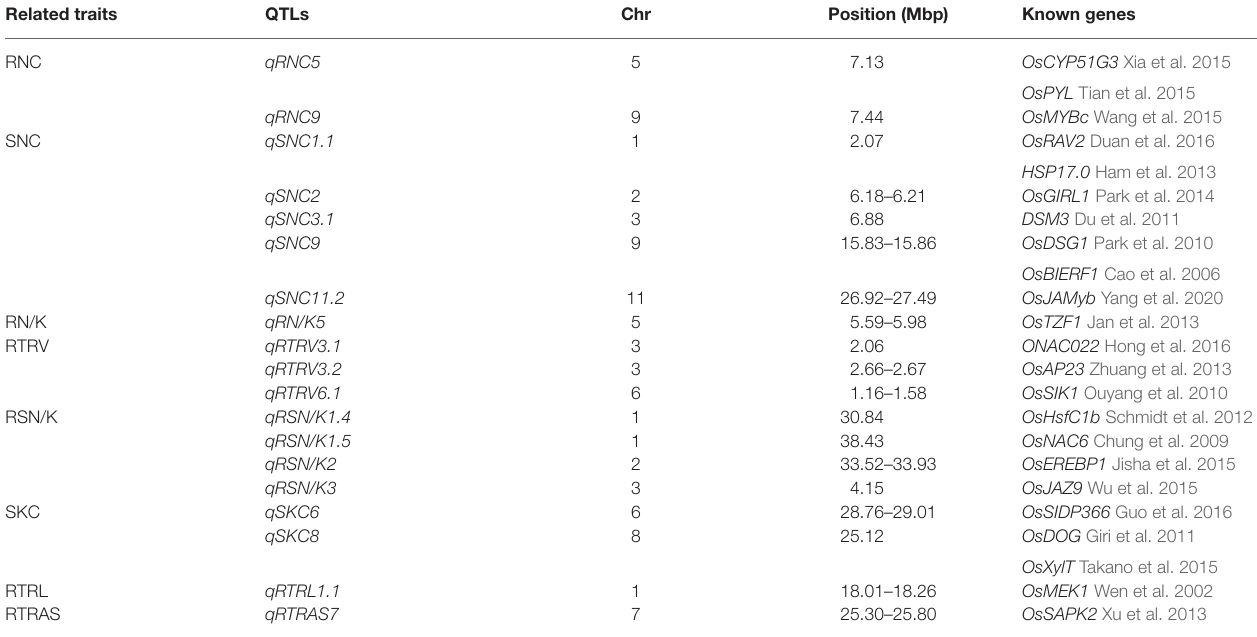
TABLE 3 | Known ST genes surrounding the mapped